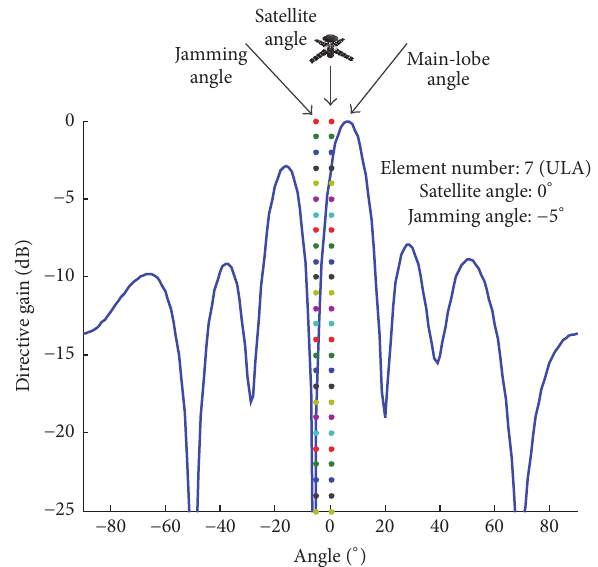
Figure 2: Effect of main-lobe jamming on satellite signal